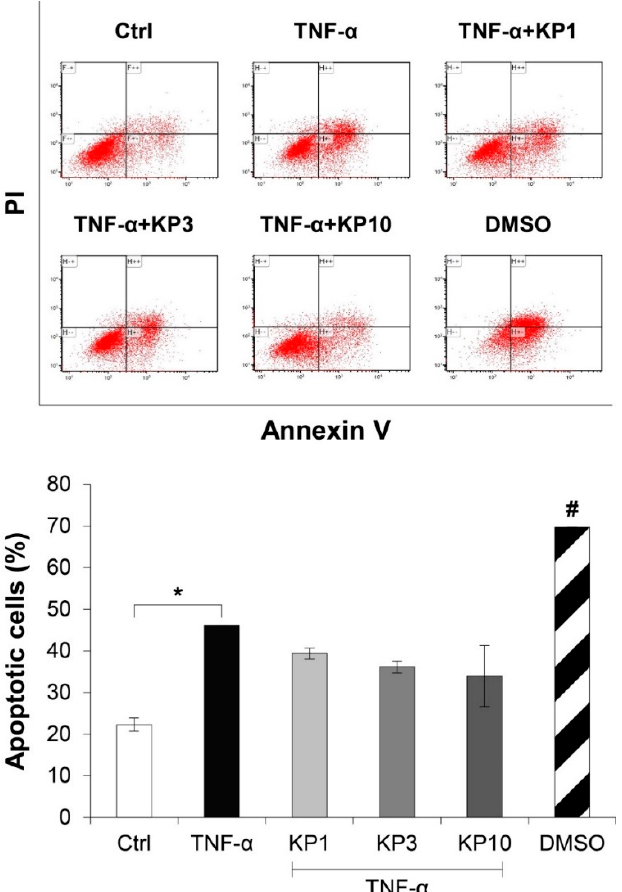
Figure 6. KP extract reduces the number of apoptotic cells. SW1353 cells were pretreated with TNF- α 50 ng/mL for 2 h and followed by co-treatment with the KP extract (1, 3, and 10 μ g/mL) for another 48 h. DMSO (2.5%) was used as a positive control. The untreated group was left as a control (Ctrl). The number of apoptotic cells was counted by flow cytometry. The significant increase in apoptotic cells induced by TNF- α is counteracted by the KP extract, lead to a decreasing trend of the apoptotic cell number. Results represent mean ± SD of two independent experiments. One-way ANOVA followed by the post hoc Tukey multiple comparison test was used to analyze the statistical difference (* p < 0.05 and # p < 0.001 compared to the untreated control).